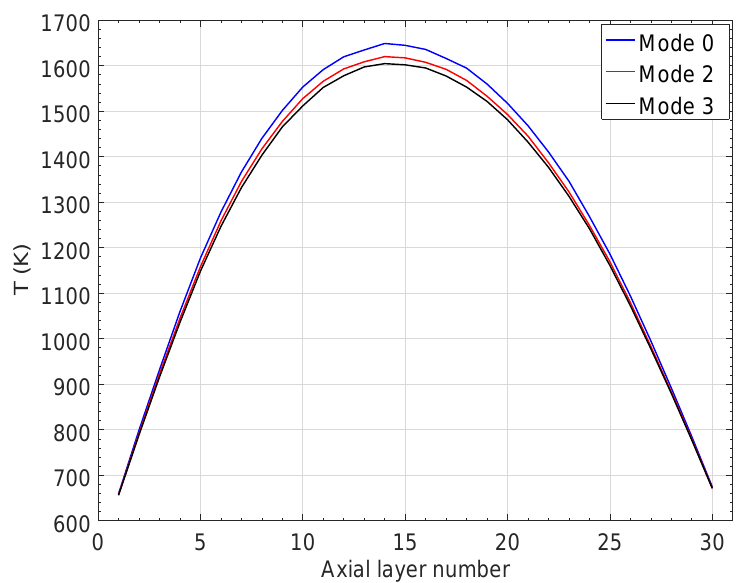
Figure 2: Fuel Centreline Temperature Profile in Rod